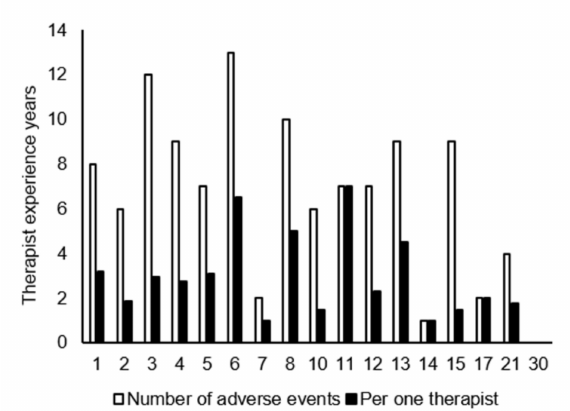
Figure 4. Number of adverse events by years of therapist experience. Per one therapist means the number of occurrences divided by the number of therapists enrolled in each year of experience. A clerical staff member was excluded for causing one adverse event.